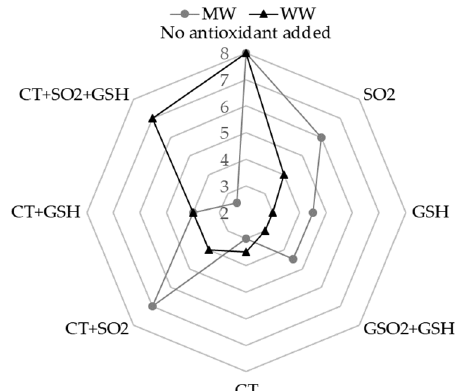
Figure 1. Sensory perception of the descriptor “cooked cabbage” related to the light-struck taste for both model wine solution (MW) and white wine (WW) both stored in the dark after light exposure.